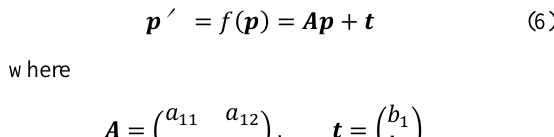
Figure 8: Affine transformation between the image of the view camera and the